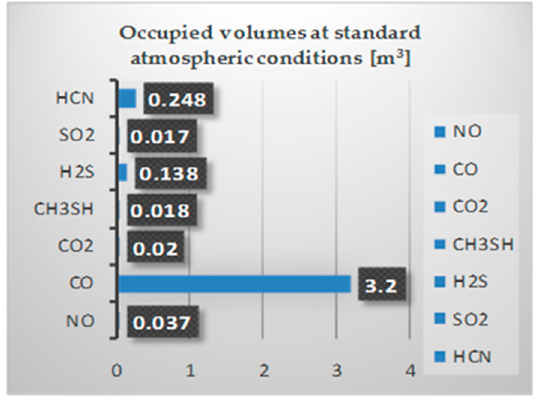
Figure 2. Occupied volumes at standard atmospheric